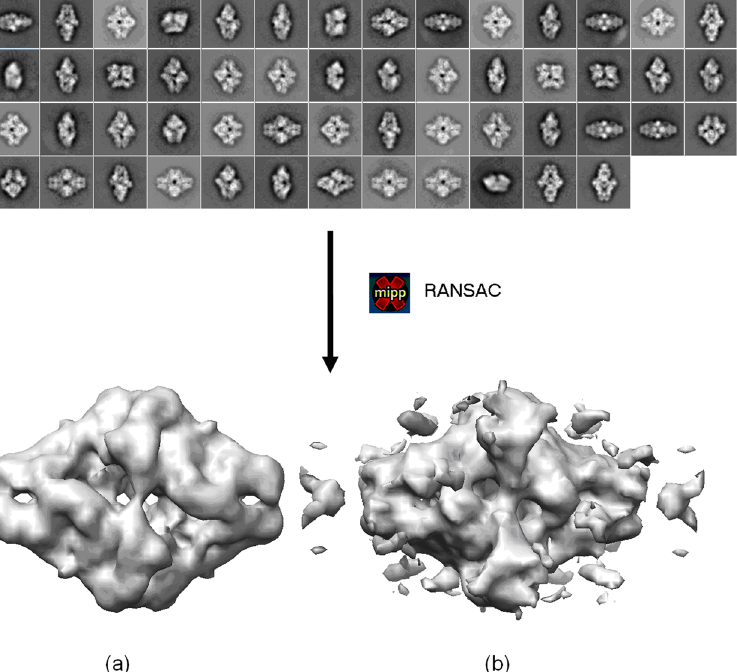
Figure 8. Experimental class averages of β -galactosidase particles and obtained “good” ( a ) and “bad” quality ( b ) ab initio initial volumes.